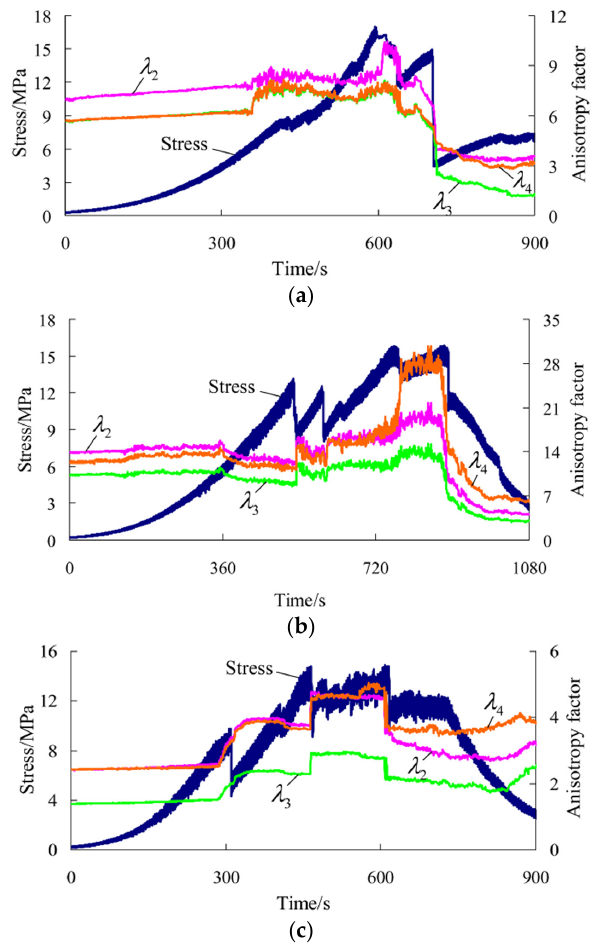
Figure 8. Stress ‐ time curve and time ‐ varying curve of the anisotropy factor in each direction during the whole process of uniaxial compression for rock samples normal to the bedding direction. ( a ) Rock sample 5 ‐ 1; ( b ) Rock sample 5 ‐ 2; ( c ) Rock sample 6 ‐ 4.